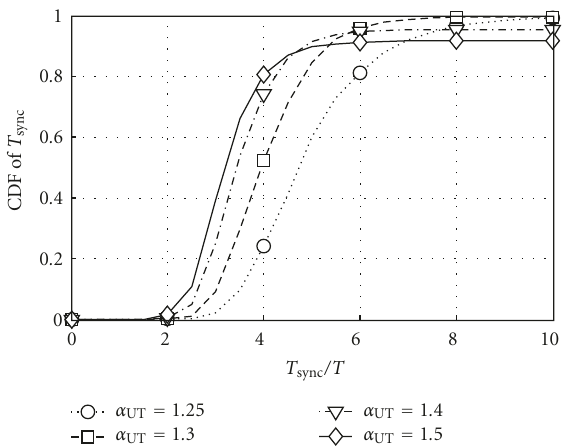
Figure 9: CDF of the normalized time to synchrony in the considered indoor environment when varying the BS-UT coupling.